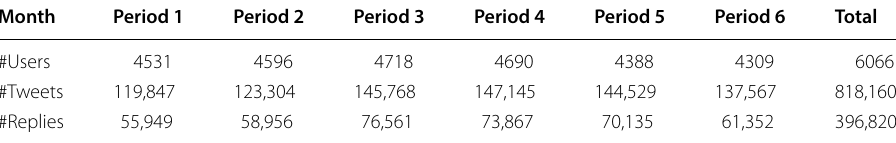
Table 7 Total monthly count of users, tweets and replies